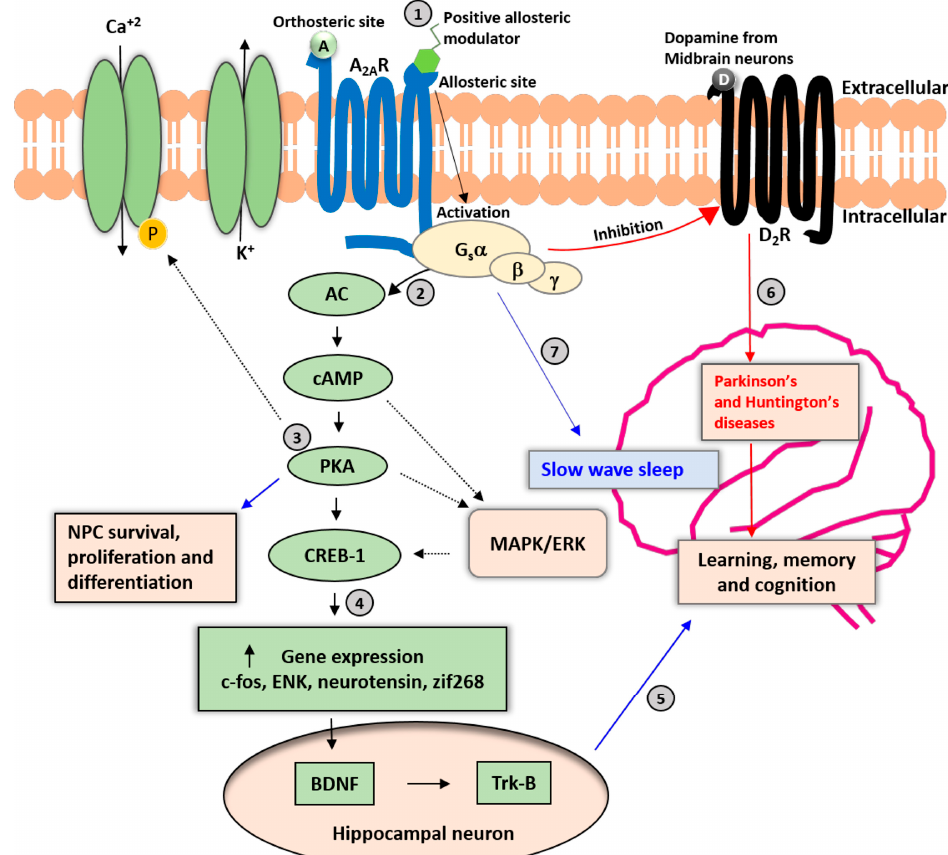
Figure 1. Neuronal A 2A R signaling cascades. A 2A R is a Gs(olf)-protein-coupled receptor involved in various physiologic processes. (1) The allosteric modulation sites may be pharmacologically relevant for avoiding adverse effects on the cardiovascular and other peripheral systems. (2) Binding of adenosine and an allosteric modulator to A 2A Rs enhances the activation of cyclic adenosine monophosphate (cAMP) and protein kinase A (PKA), resulting in the phosphorylation of calcium ion channels and increased influx of Ca +2 into the cytoplasm. (3) The PKA pathway also promotes neural progenitor cell (NPC) survival, proliferation, and differentiation; and activation of the mitogen- activated protein (MAP)-kinase pathway. (4) PKA-mediated phosphorylation of the cAMP-responsive element binding protein 1 (CREB-1) regulates the expression of genes such as c-fos, enkephalin (ENK), neurotensin, and zinc finger protein 268 (zif268). (5) The secretion of brain-derived neurotrophic factor (BDNF) and activation of tropomyosin receptor kinase B (TrkB) receptors in response to A 2A R activation in hippocampal neurons may be relevant for cognitive functions such as learning and memory. (6) A 2A R activation may be a counter mechanism to control the activation and expression of dopamine D 2 receptors (D 2 Rs). Long-term imbalance of D 2 R signaling leads to impairments in cognitive and motor functions and the development of Parkinson’s and Huntington’s diseases. (7) Activation of A 2A R in the nucleus accumbens increases slow-wave sleep in mice. Solid black arrows represent the primary signaling pathway of A 2A Rs, and dashed black arrows represent secondary signaling pathways. A: Adenosine; D: